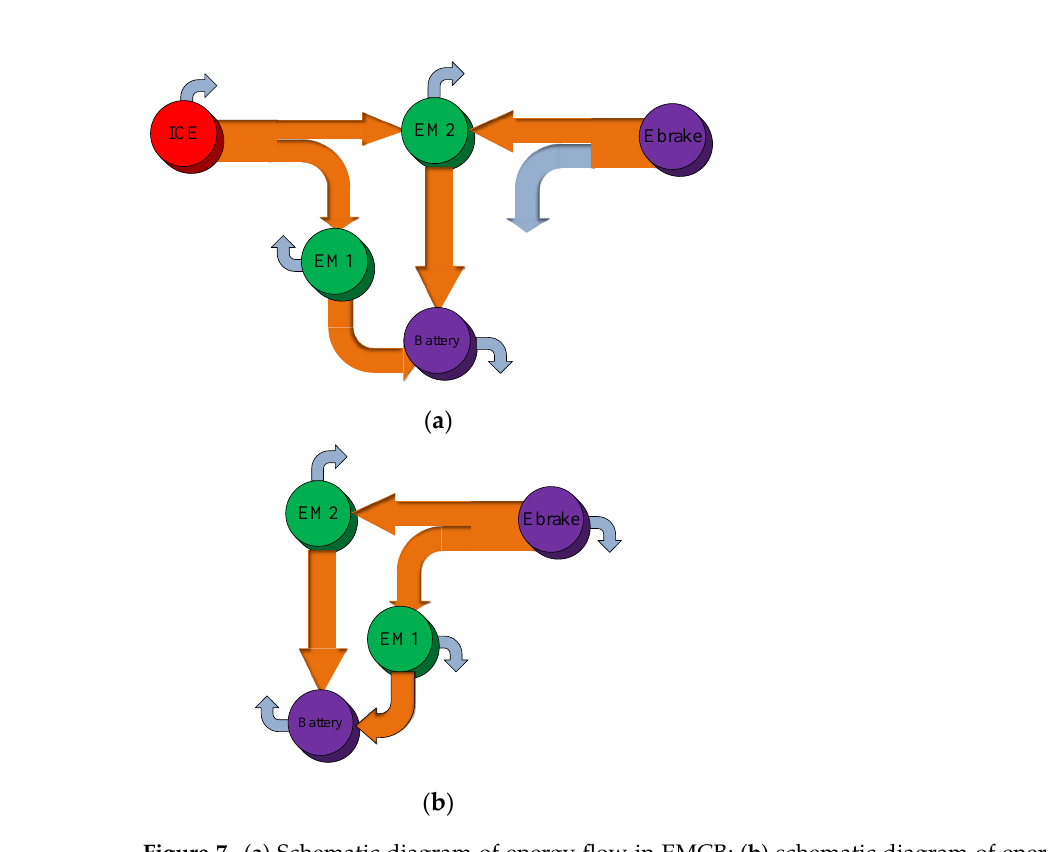
Figure 7. ( a ) Schematic diagram of energy flow in EMCB; ( b ) schematic diagram of energy flow in DMB.